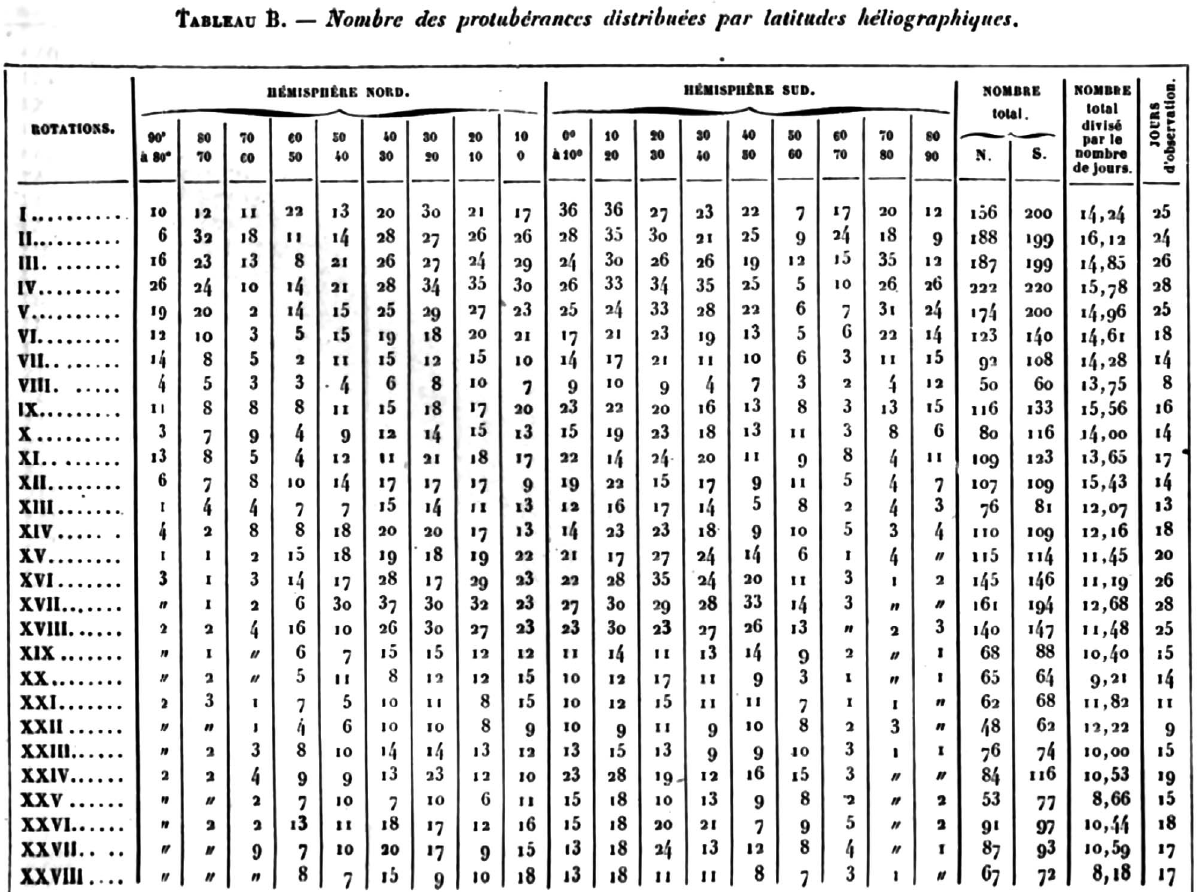
Fig. 3. Table B published by Secchi, including information on the distribution of prominences in heliographic latitudes [source: Secchi, 1875, p.